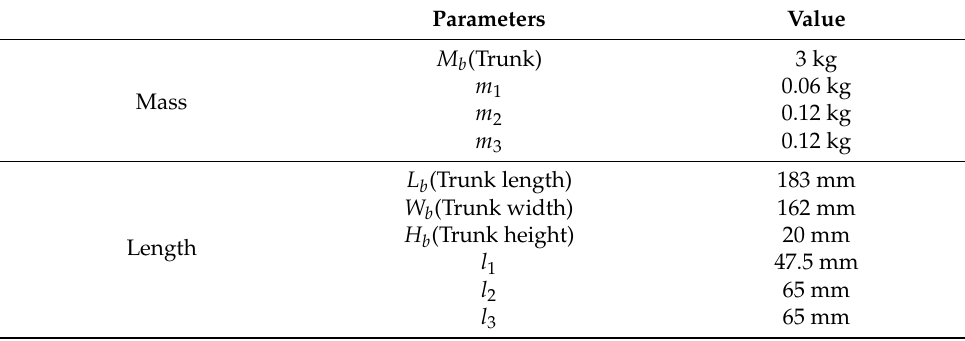
Table 2. Parameters in the simulation.